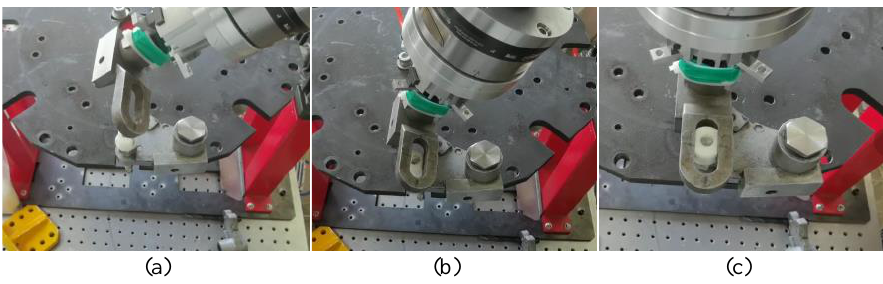
Figure 14. Key-slot hole searching and insertion process. ( a ) pre-insertion stage; ( b ) hole-searching stage; ( c ) insertion stage.